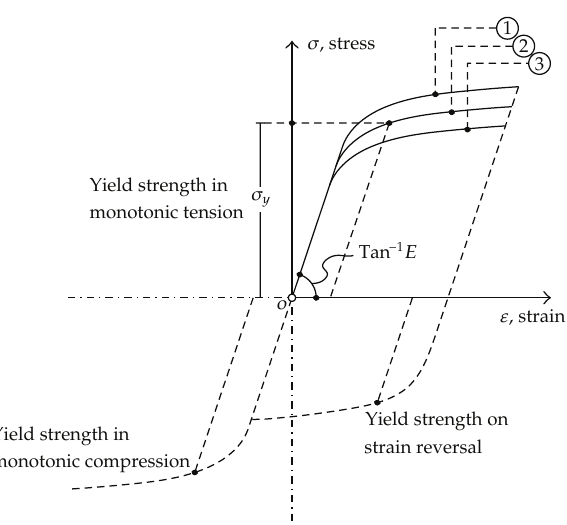
Figure 5: Stress-strain curves for the material regions (cid:6) 1 (cid:7) through (cid:6) 3 (cid:7)